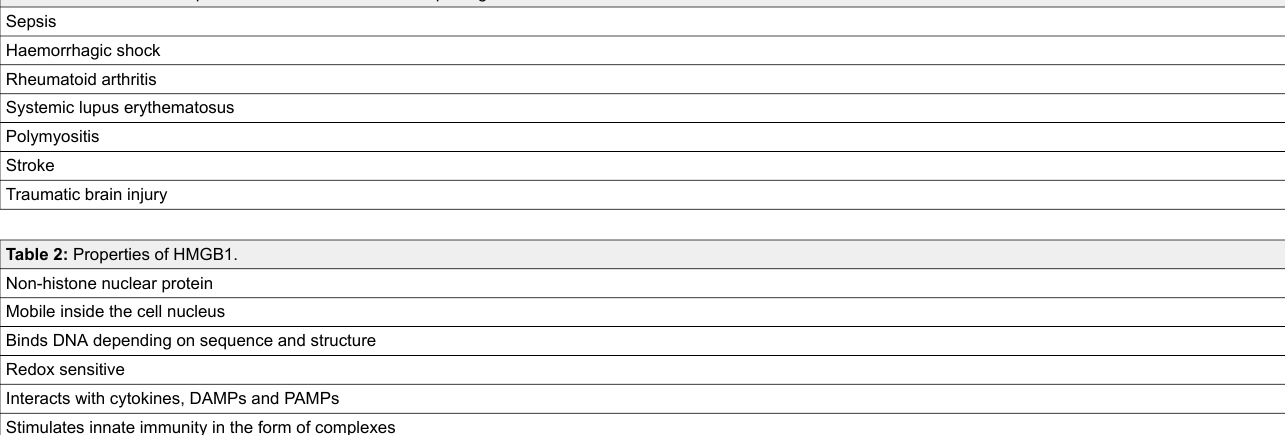
Table 1: Diseases with a potential role of HMGB1 in their pathogenesis. Sepsis Haemorrhagic shock